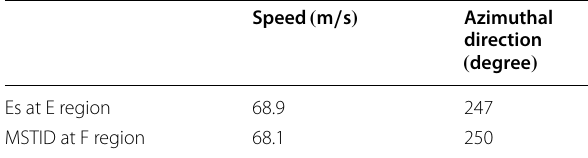
Table 1 Propagation speeds and directions of Es/MSTIDs